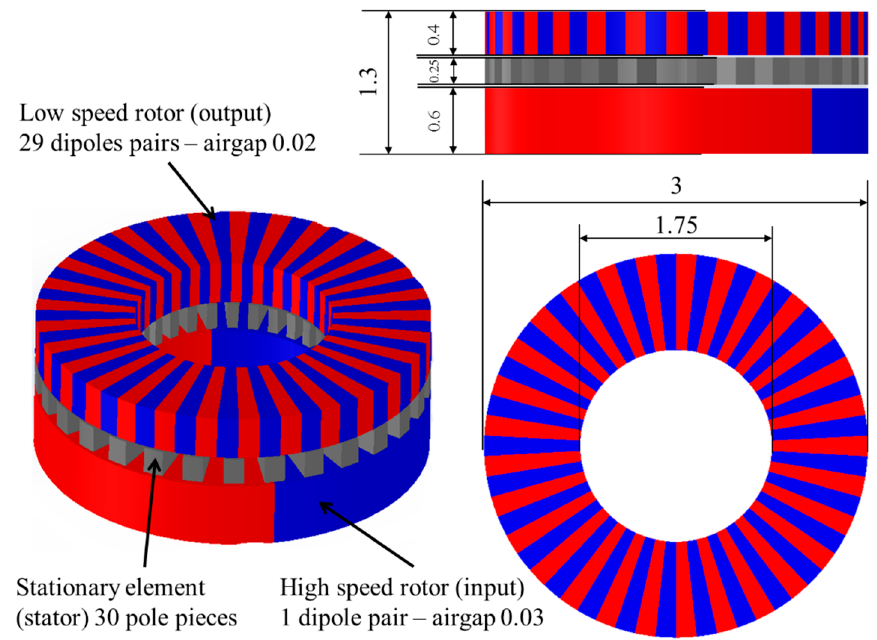
Figure 1. Micromagnetic gear design (dimensions in mm).